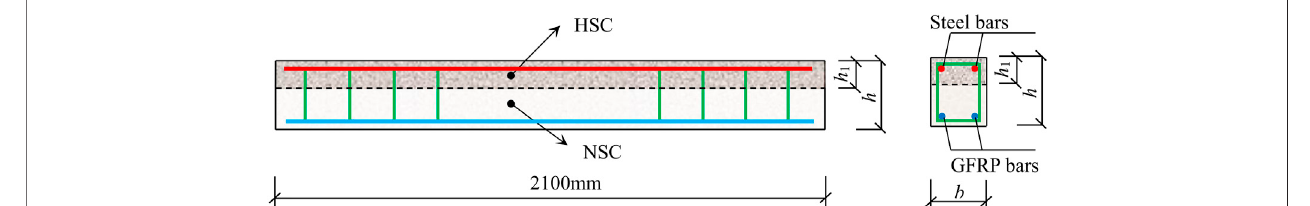
FIGURE 1 | Reinforcement mode of